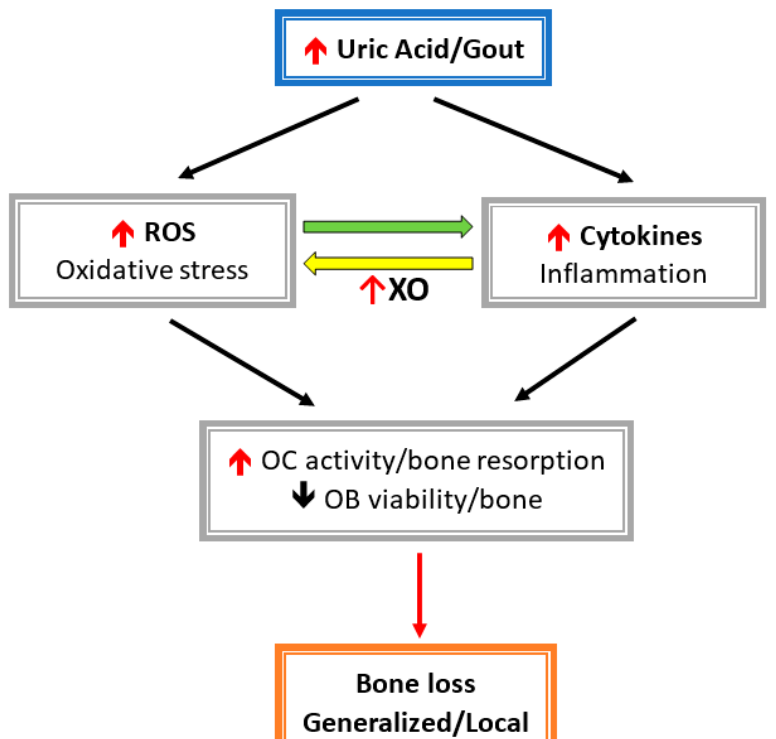
Figure 2. Hyperuricemia-/gout-induced inflammatory cytokines and related reactive oxygen species (ROS) activate osteoclast (OC) activity and inhabit osteoblast cell (OB) viability. Cytokines induce oxidative stress via xanthine oxidase (XO), then leads to enhanced bone loss.